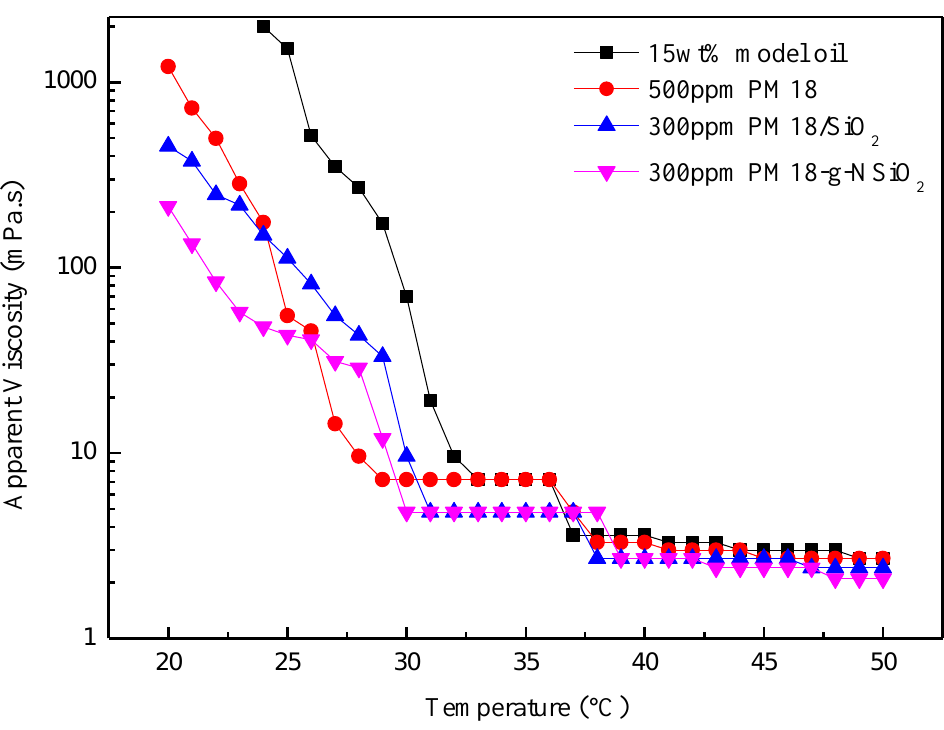
Figure 4. Semi-logarithmic curves of the viscosity versus temperature for the 15% wax model oil untreated and treated with PM18-NSiO 2 .